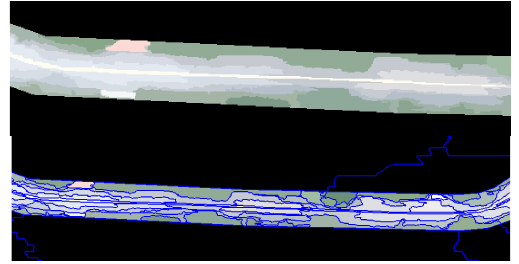
Figure 4. Large-scale Segmentation result (part)